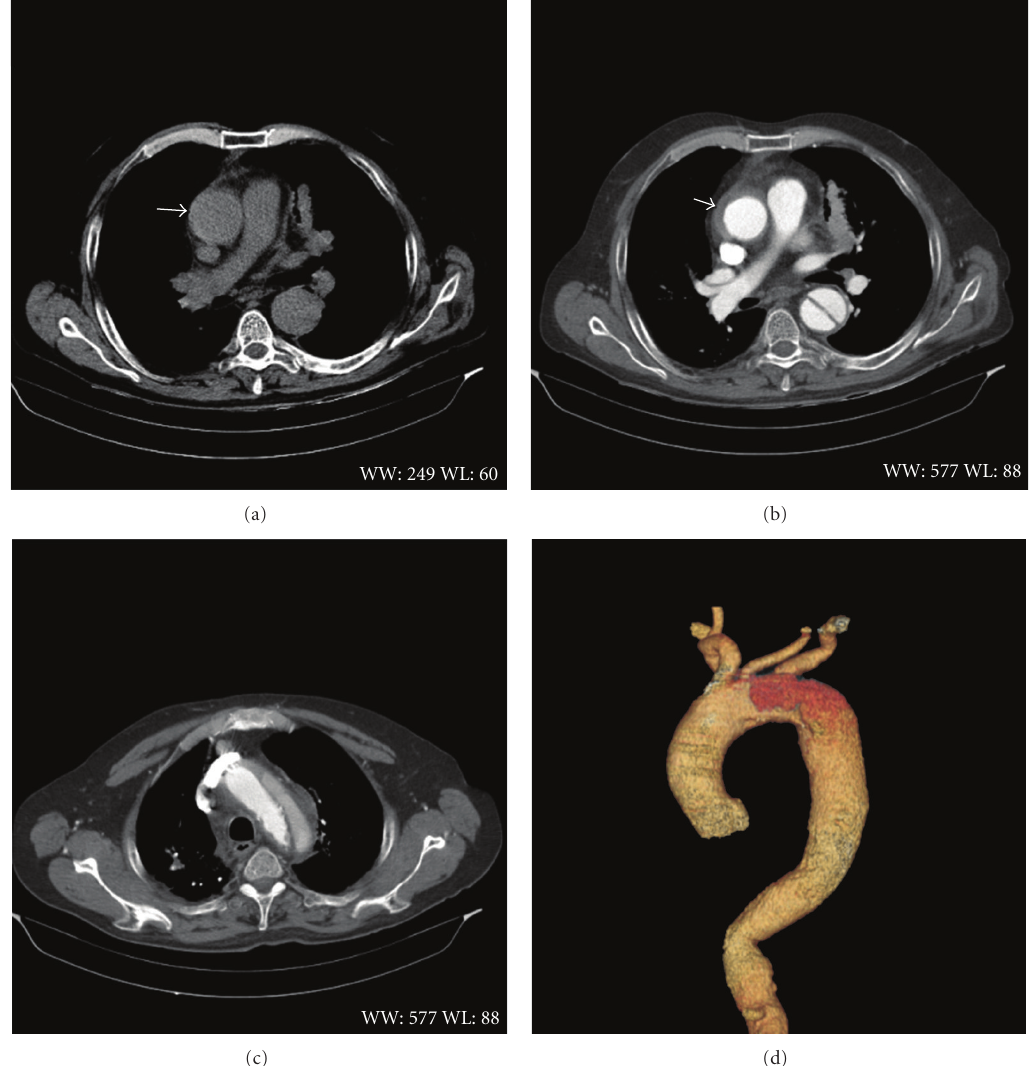
Figure 1: ((a) and (b)) Preoperative computed tomography images demonstrating intramural hematoma in the ascending part of aorta. (c) Reveal classic dissection of the aortic arch with false and true lumen. (d) Reconstructed